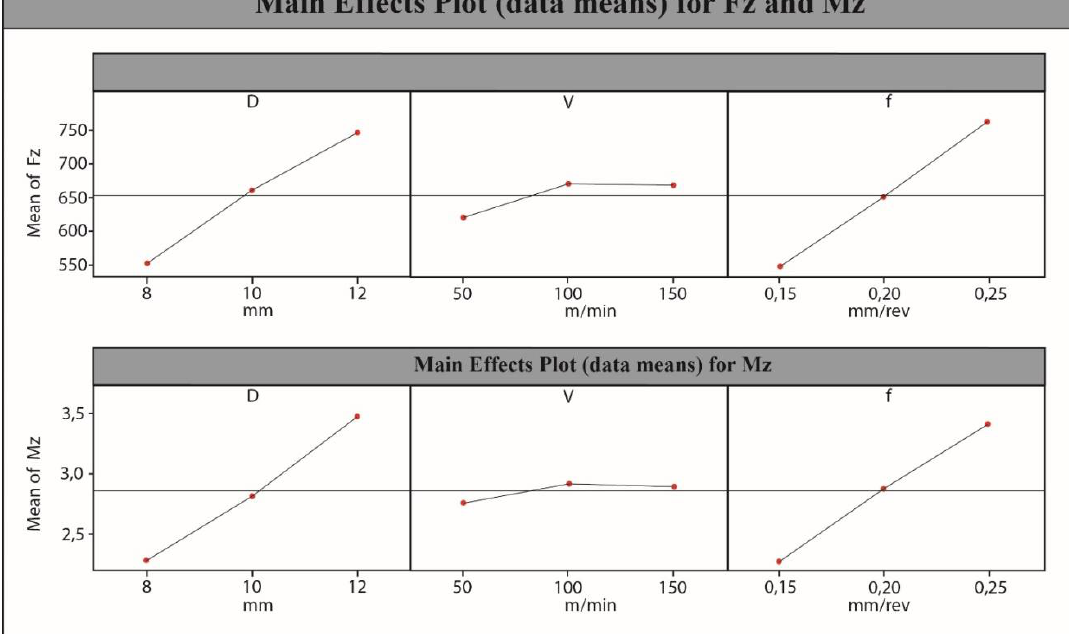
Figure 5. Main effects plot for F z and M z . Machines 2018 , 6 , x FOR PEER REVIEW